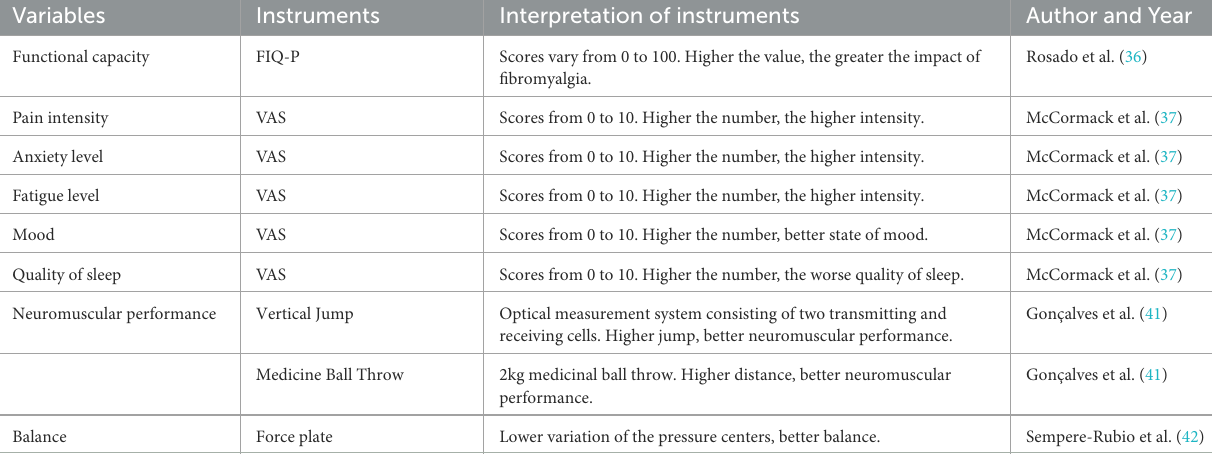
TABLE 1 Variables, instruments, interpretation, and reference for